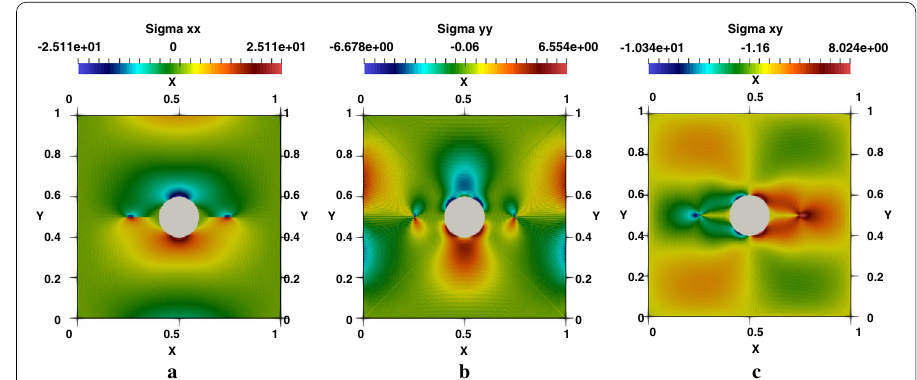
Fig. 15 Square plate with round hole, R / L = 0 . 2, l / L = 0 . 3: a σ xx -stress, b σ yy -stress, c σ xy -stress